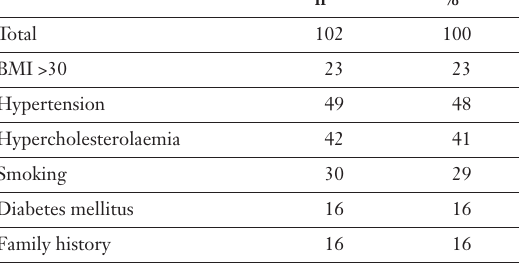
Cardiovascular risk factors in